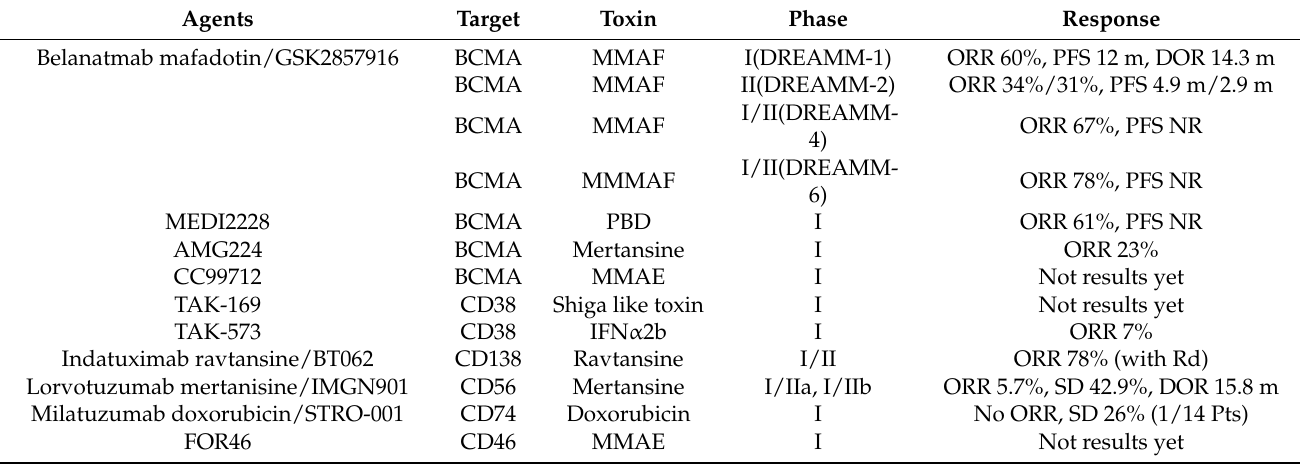
Table 3. Antibody drug conjugate (ADC) in